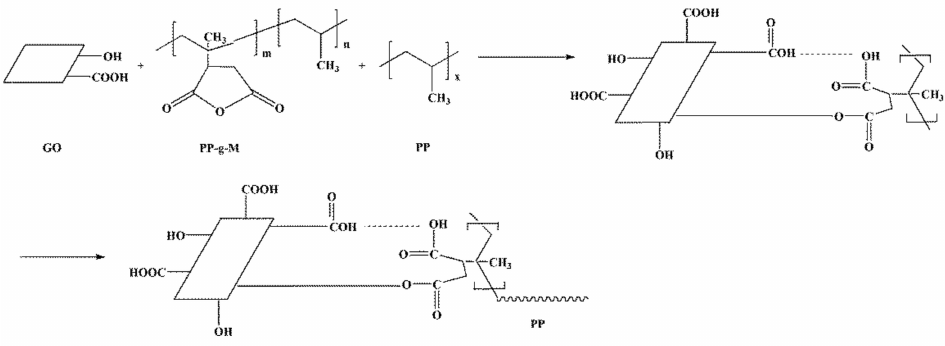
Figure 3. Composite fiber reaction mechanism